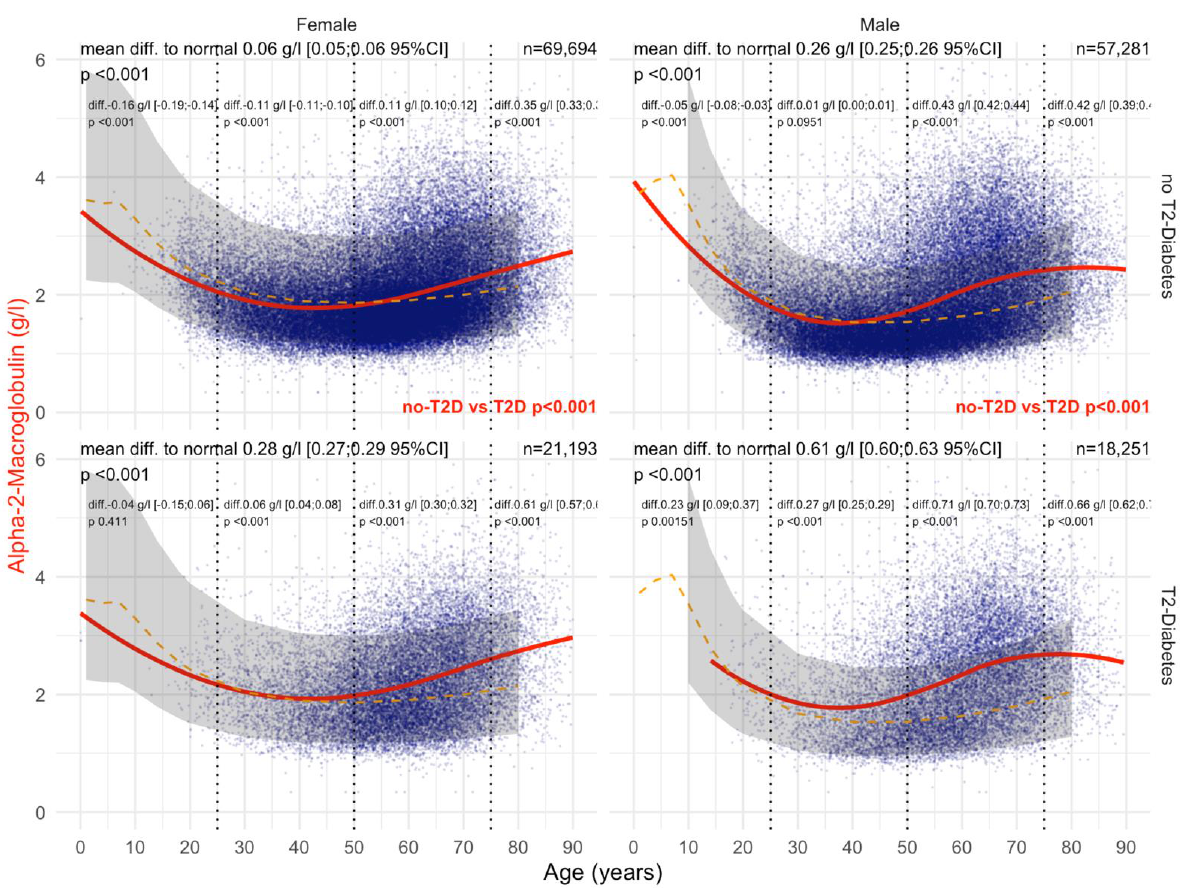
Figure 13. A2M levels during the COVID-19 pandemic. Impact of T2DM on A2M concentration during SARS-CoV-2 pandemic in “ NAFLD-Serum ” patients followed for metabolic liver risk (n = 173,246). Normal serum means values according to age and sex (dashed – orange lines), with 95% confidence intervals (gray ribbon). Three vertical – dotted lines mark the four age groups (before 25, between 25 and 50, between 50 and 75, and above 75 years old). The red curve is a Loess regression of the median of A2M values. For each age group, the mean difference (%95CI) between the patient protein value and the expected normal (for age and sex) with its significance p -value is displayed at the top of the figure. The significance between the non-T2DM and T2DM patients is displayed in red between the 2 panels.